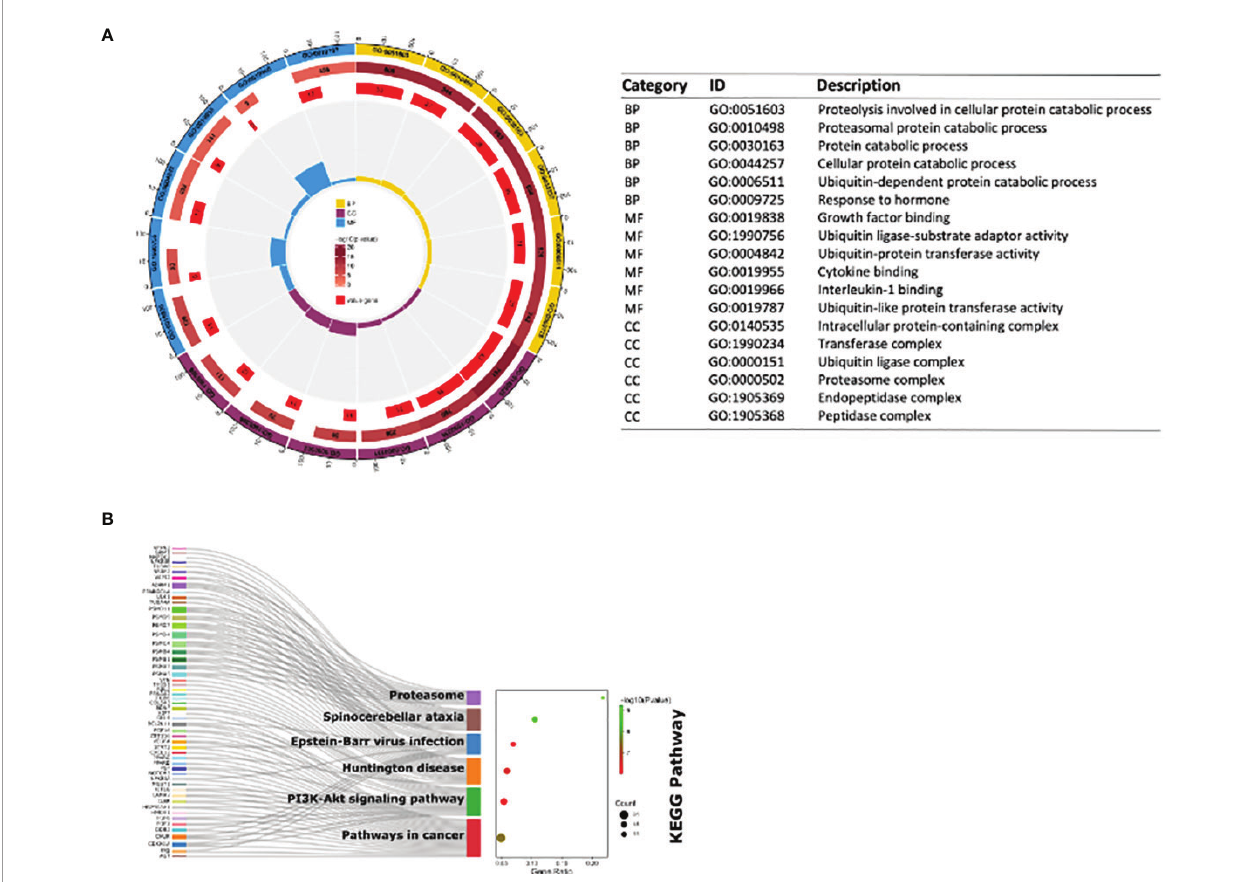
FIGURE 4 | GO enrichment and KEGG pathway of shared DE-mRNAs in mouse myocardial tissues in GSE179554 and GSE40180 datasets. (A) GO term enrichment analysis results. The circle diagram shows the top 6 GO enriched terms in BP, MF, and CC. GO term enrichment analysis results. The circle diagram is from outside to inside: the outermost circle represents the term of GO; the second circle represents the total number of enriched genes in that term; the darker the color, the smaller the P-value of the entry; the third circle represents the number of overlaps between our input genes and the total genes of the entry; the circular histogram in the middle represents the enrichment ratio of the input gene. The higher the column, the more obvious the enrichment degree. (B) The bubble plot shows the most enriched KEGG pathways of DE-mRNAs. The most signi fi cant KEGG pathways are involved in proteasome, spinocerebellar ataxia and Epstein – Barr virus infection pathway. GO, Gene Ontology; BP, biological process; MF, molecular function; CC, cellular components; KEGG, Kyoto Encyclopedia Genes and Genomes; the screening criteria for signi fi cant enriched biological processes and pathways were Q < 0.05. The Q-value is the adjusted